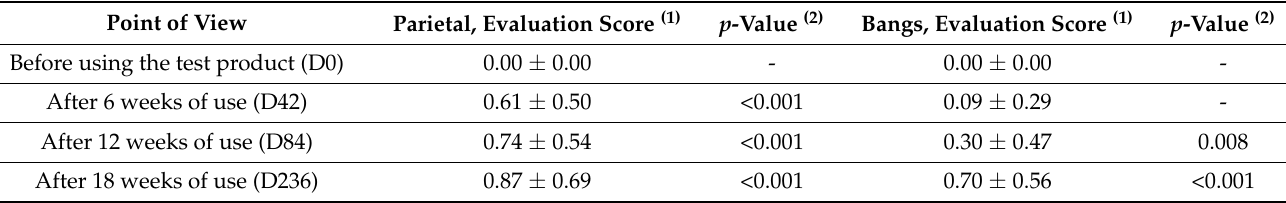
Table 2. Visual evaluation for the crown of the head and forehead